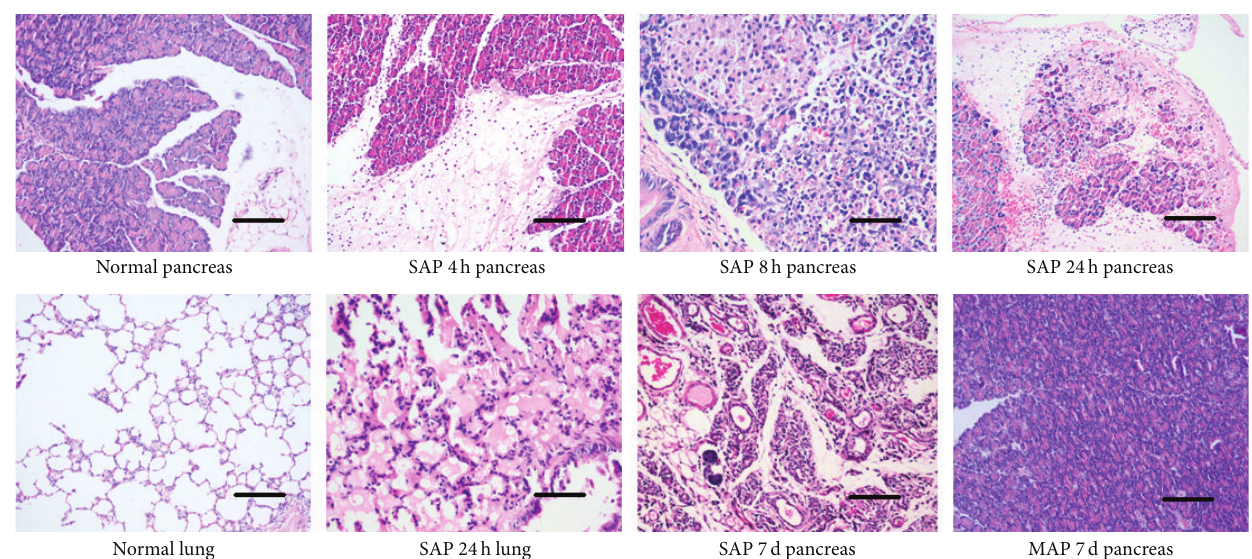
Figure 1: Histological findings of pancreatic and pulmonary tissues after AP. The scale bars are equal to 100 𝜇 m in all of the images. (Normal pancreas) pancreatic acini of a control animal; the glandular architecture was entirely normal (H&E, × 200). (SAP 4h pancreas) pancreatic interstitial edema and infiltration of a great deal of inflammatory cells 4 h after SAP (H&E, × 200). (SAP 8h pancreas) necrosis of pancreatic acini and hemorrhage in parenchyma 8 h after SAP (H&E, × 200). (SAP 24 h pancreas) severe necrosis, hemorrhage, and infiltration of inflammatory cells 24 h after SAP; structure of pancreatic acini was damaged obviously (H&E, × 200). (Normal lung) pulmonary alveoli of a control animal (H&E, × 200). (SAP 24 h lung) interstitial edema and effusion in alveolar space 24 h after SAP (H&E, × 200). (SAP 7d pancreas) seven days after SAP induction; pancreatic acini were replaced by granulation tissue and there was significant proliferation of condulets. Tubular complex formation could be found (H&E, × 200). (MAP 7d pancreas) seven days after mild acute pancreatitis induction, pancreatic tissue almost recovered and no obvious necrosis or infiltration could be found (MAP was induced by repeated cerulein intraperitoneal injection in a previous